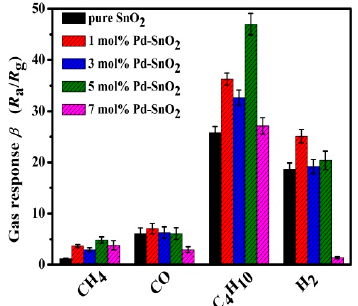
Figure 5. Gas responses of sensors based on Pd-functionalized SnO 2 nanofibers with different Pd contents to various flammable gases, all applied at a concentration of 3000 ppm and as measured at an operating temperature of 260 ◦ Table 1. Comparison of gas-sensing performances of sensors based on various nanostructural materials toward butane.